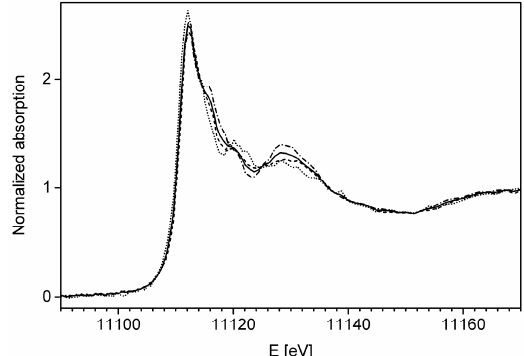
Figure A1. Ge K XANES spectra from three different positions on the willemite sample ( dashed , dotted , dash-dotted ). Variations in the shape of the spectra are most probably due to orientation effects of the crystallites to the polarized synchrotron beam. The merged spectrum ( solid line ) is used for further data interpretation in the manuscript.